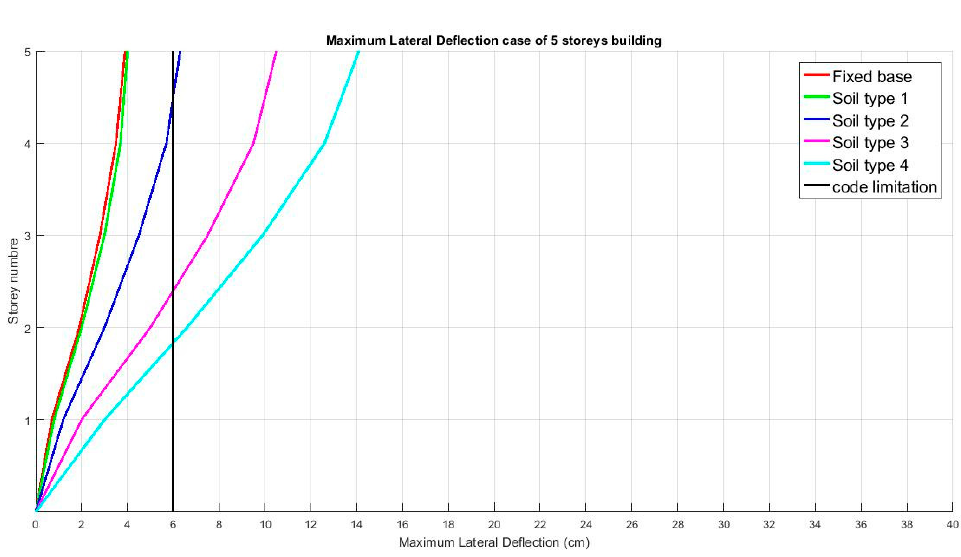
Figure 4. Concept of P-delta effect: example of single degree of freedom.